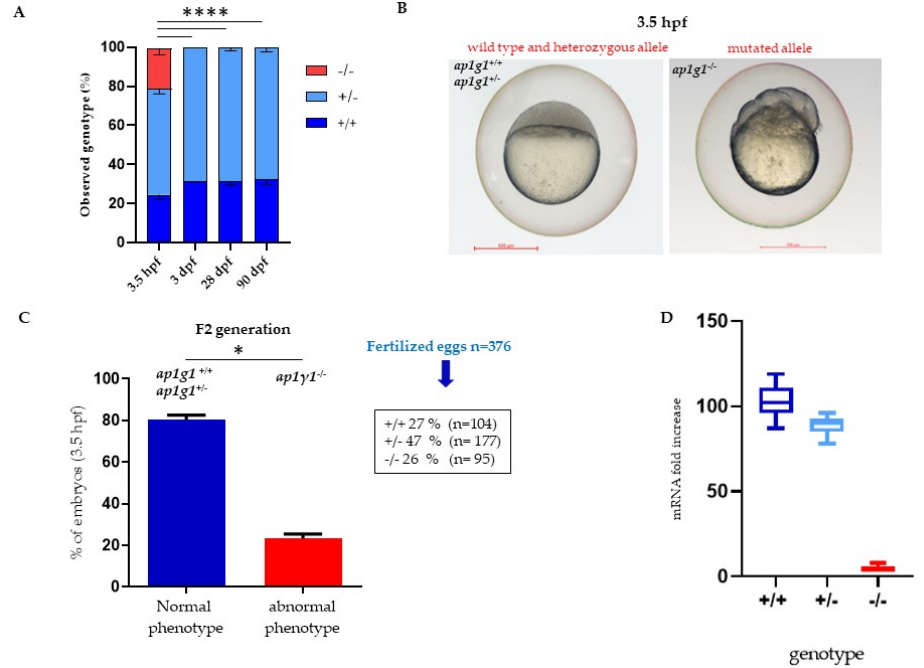
Figure 1. Characterization of ap1g1 mutant embryos and larvae. ( A ) Representative images of genotype distribution at different developmental stages. Data derived from five different matings with n = 100 in each mating. For genotyping see Math and Met Section. ( B ) Comparison of the morphological phenotype of embryos derived from F2 generation (F1 ap1g1 +/ − × F1 ap1g1 +/ − ) at 3.5 hpf. ( C ) In the graph blue bar indicates the percentage (%) of embryos with +/+ and +/ − genotype and normal phenotype, the red bar indicates the embryos with − / − genotype and abnormal phenotype. The data represent one experiment out of three with n = 376 embryos. (* p < 0.05, **** p < 0.0001 One-way ANOVA + Newman-Keuls). Size bar = 500 µ m; ( D ) qPCR analysis of ap1g1 transcript from ap1g1 +/+ ; ap1g1 +/ − and ap1g1 − / − embryos at 24 hpf. Gene expression was normalized using rpl13a as a reference gene and expressed as the mRNA fold